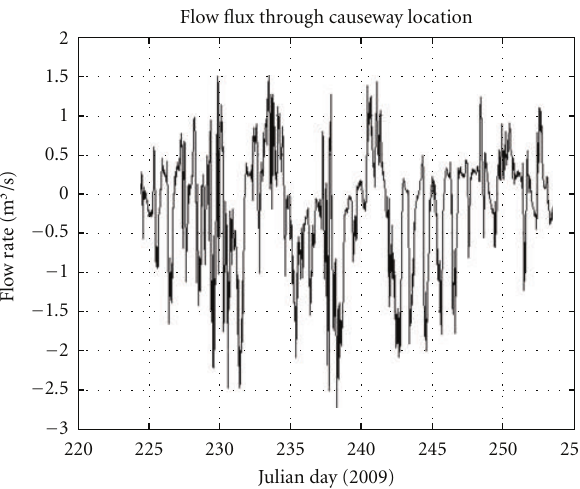
Figure 16: The exchange flow rate (m 3 /s) through a 15-meter-wide opening in the middle of the causeway induced by the measured natural